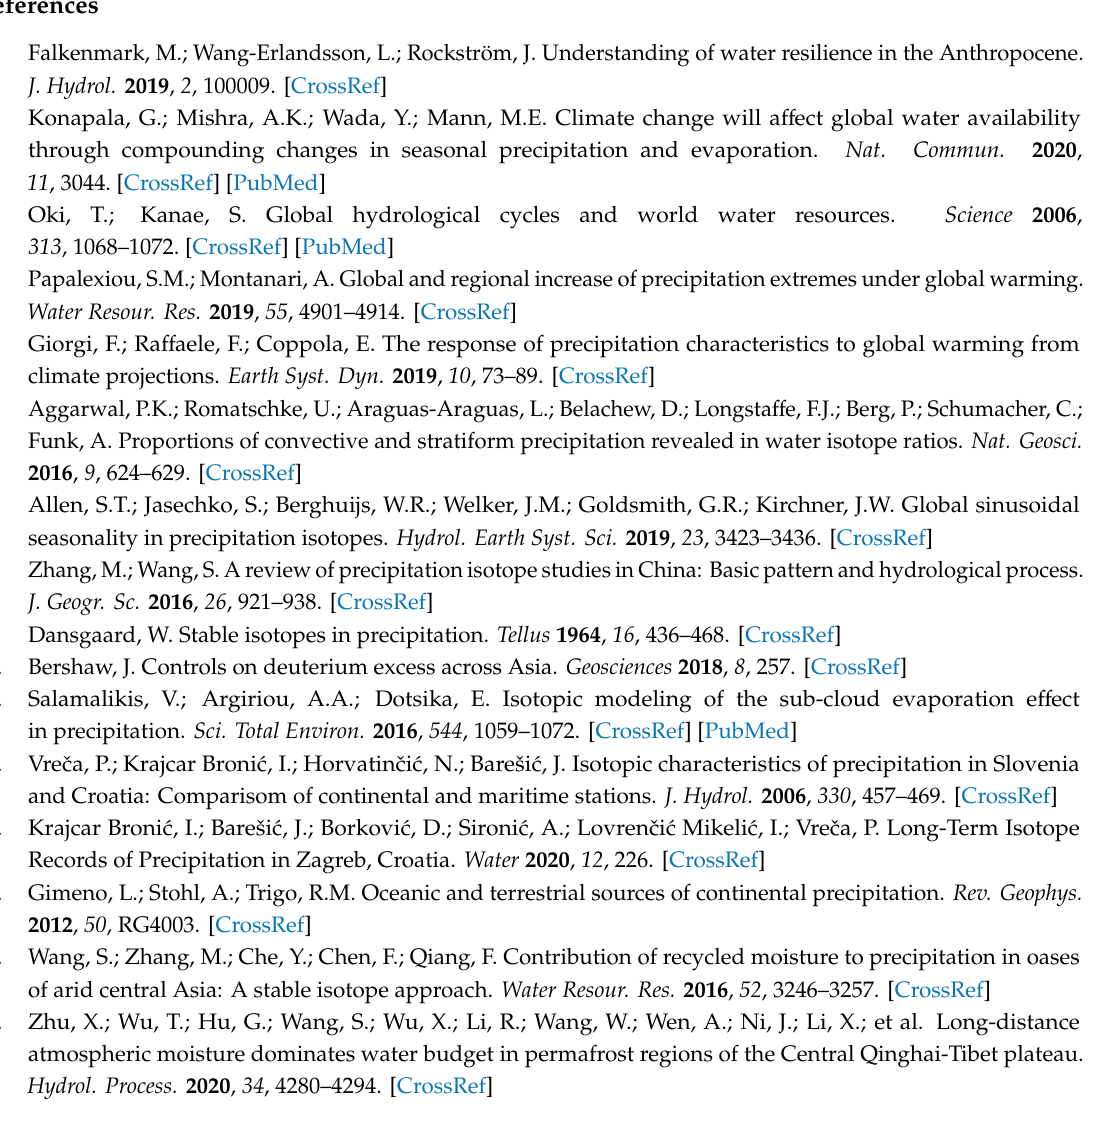
Figure S1: Variation of monthly d value at the GNIP Lanzhou station. Figure S2: Correlations between d value and air temperature ( a ) or water vapor pressure ( b ) at the GNIP Lanzhou station. Figure S3: Clustered backward trajectories during di ff erent seasons to the Lanzhou city in 2011. Figure S4: Clustered backward trajectories during di ff erent seasons to the Lanzhou city in 2012. Figure S5: Clustered backward trajectories during di ff erent seasons to the Lanzhou city in 2013. Figure S6: Clustered backward trajectories during di ff erent seasons to the Lanzhou city in